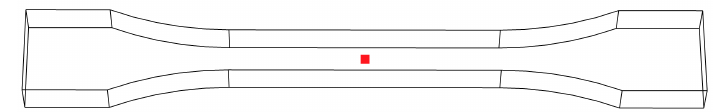
Figure 13. Location of the temperature measurement point (middle point).